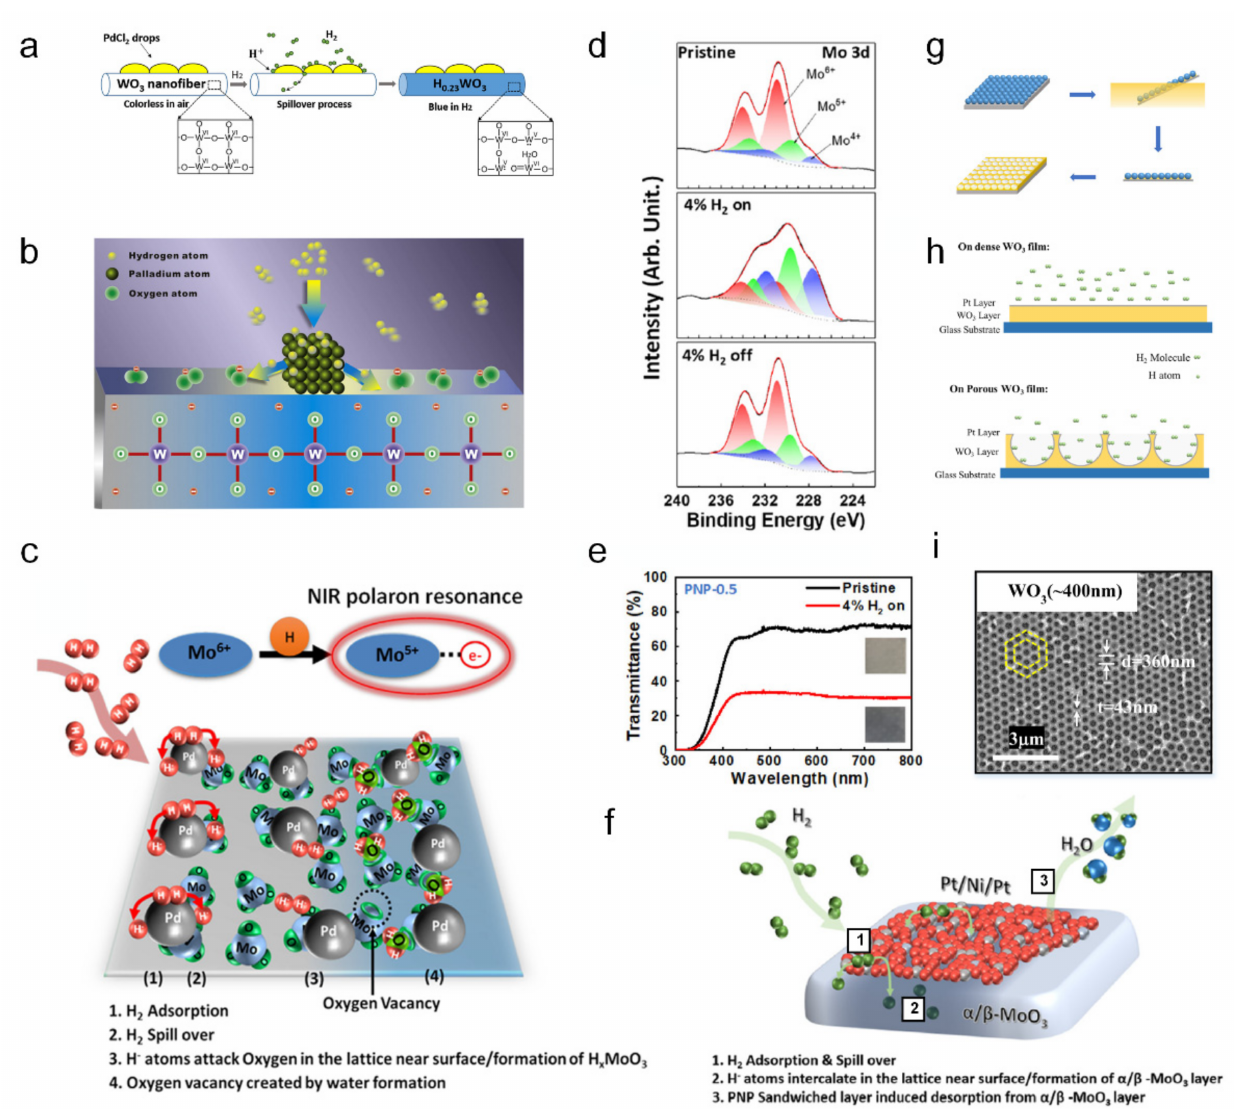
Figure 7. The gasochromic mechanisms of transition metal oxides with noble metal catalysts (( a ) adapted with permission from ref. [74], copyright 2018 Elsevier, ( b ) adapted with permission from ref. [76], copyright 2014 Elsevier, ( c ) adapted with permission from ref. [77], copyright 2017 Elsevier, ( d – f ) adapted with permission from ref. [83], copyright 2021 Elsevier, and ( g – i ) adapted with permission from ref. [85], copyright 2022 Springer). The schematic of the mechanism for ( a ) a gasochromic PdCl 2 -WO 3 nanofiber and ( b ) Pd-WO 3 film with H 2 molecule. ( c ) XPS spectra of the Pt/Ni/Pt-0.5/MoO 3 film before, during, and after H 2 exposure. ( d ) Visible spectra transmittance of the pristine WO 3 (black line) and H 2 exposure states. (redline) ( e ) The illustration of the H 2 sensing mechanism for the Pt/Ni/Pt-0.5/MoO 3 film. ( f ) Suggested H 2 sensing mechanism for the Pt/Ni/Pt-MoO 3 composite. ( g ) Schematic of the porous WO 3 fabrication by the polystyrene template method. ( h ) Conceptual comparison between dense WO 3 and porous WO 3 films with H 2 . ( i ) SEM image of the fabricated porous WO 3 film of 360 nm